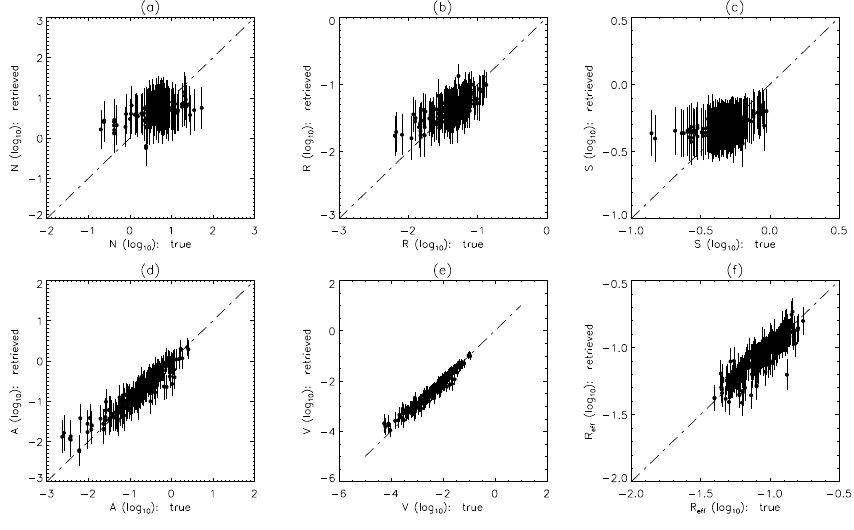
Fig. 4. As Fig. 3 but for the Maximum Noise Scenario.